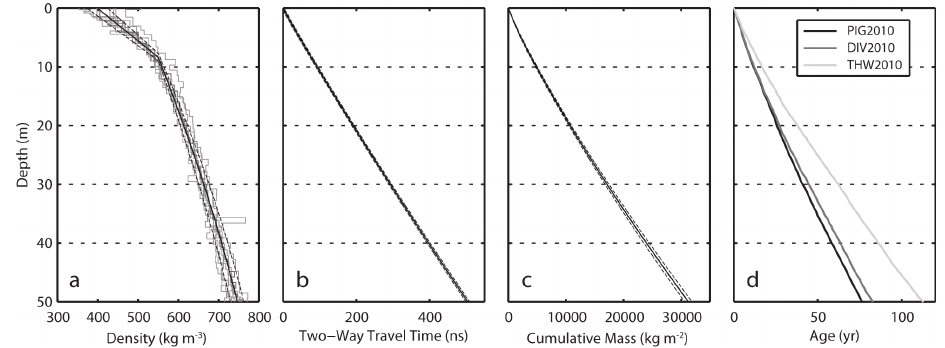
Figure 3. Profiles of (a) density, (b) two-way travel time, (c) cumulative mass, and (d) age with depth. (a) The density profiles from nine firn cores from the region are plotted in light grey and the model fit to their mean is shown as a solid black line. The dashed black lines show ± 1 standard deviation ( σ ) from the mean. ( b) The solid line was produced using the formula, d = 0 . 5 cτε − 0 . 5 , for conversion between two-way travel time and depth using the density model in (a) , and the dashed lines were generated from the ± 1 σ deviations in (a) . (c) The cumulative mass profiles were created by integrating the mean (solid) density profile with depth as well as the ± 1 σ deviations (dashed) from (a) . (d) The depth–age profiles for the three 2010 cores determined from glaciochemical analysis.